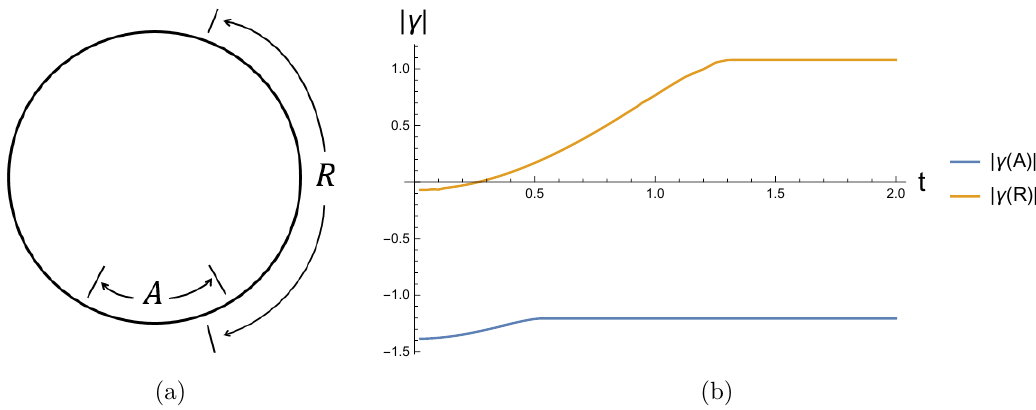
Figure 8. (a) Choice of the regions A and R . (b) Lengths of the HRT surfaces j (cid:13) ( A ) j and j (cid:13) ( R ) j as functions of